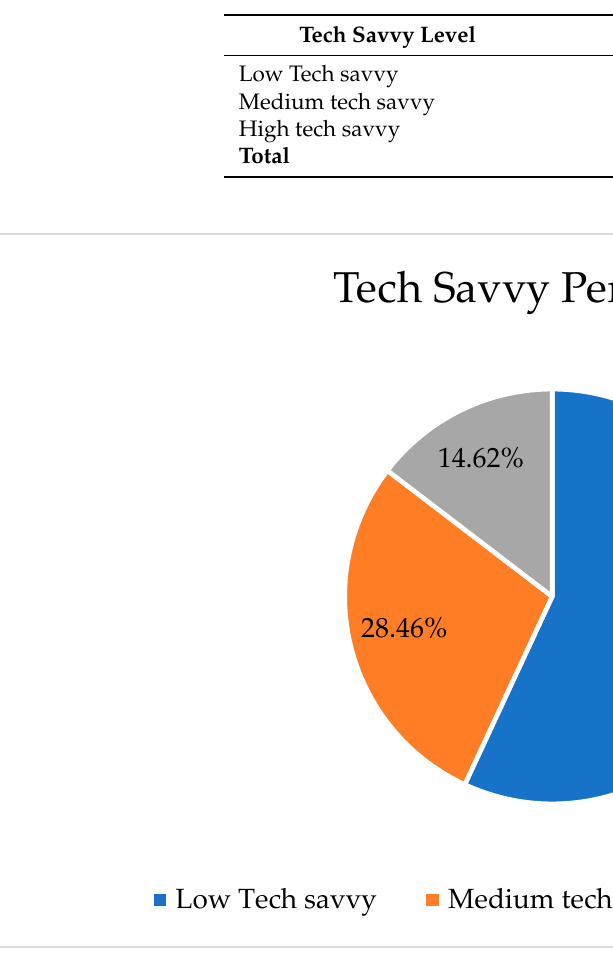
Figure 6. The percentage of technology savvy level.